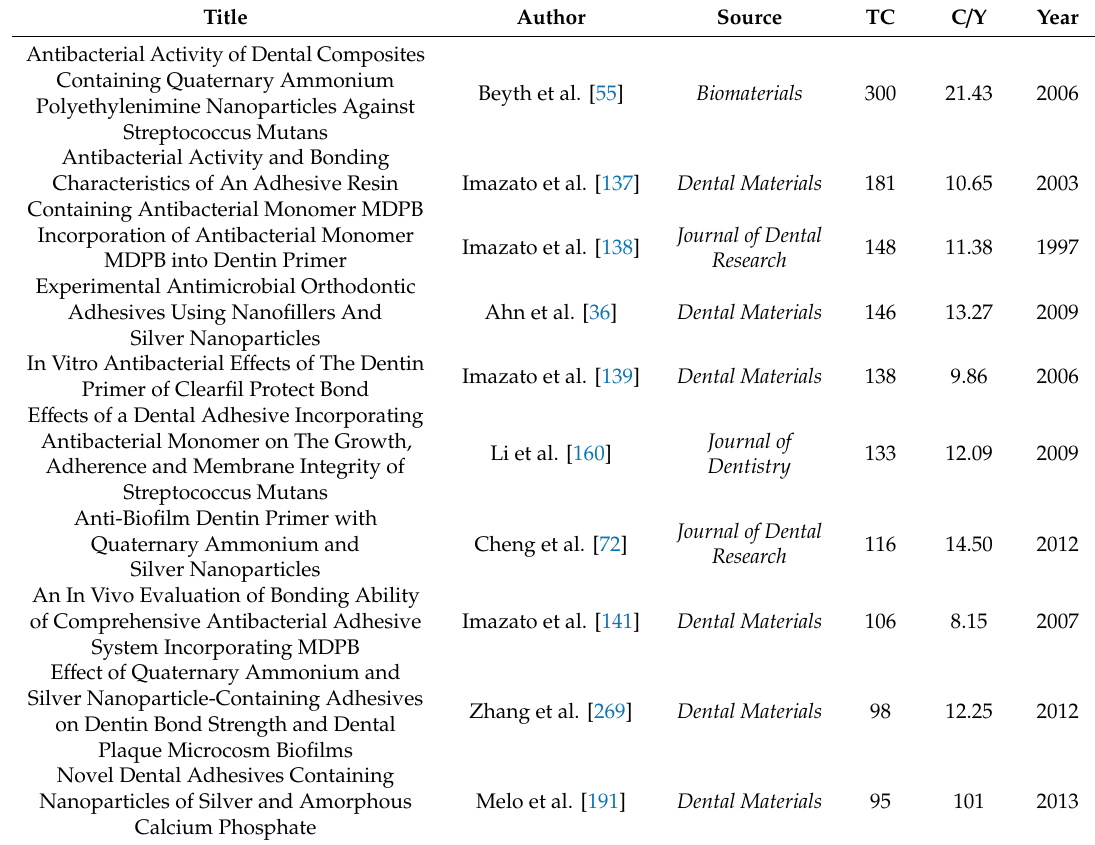
Table 3. Top 10 highly cited articles on antibacterial dental